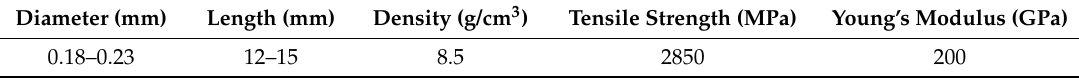
Table 2. Mechanical properties and geometric parameters of steel fibers.